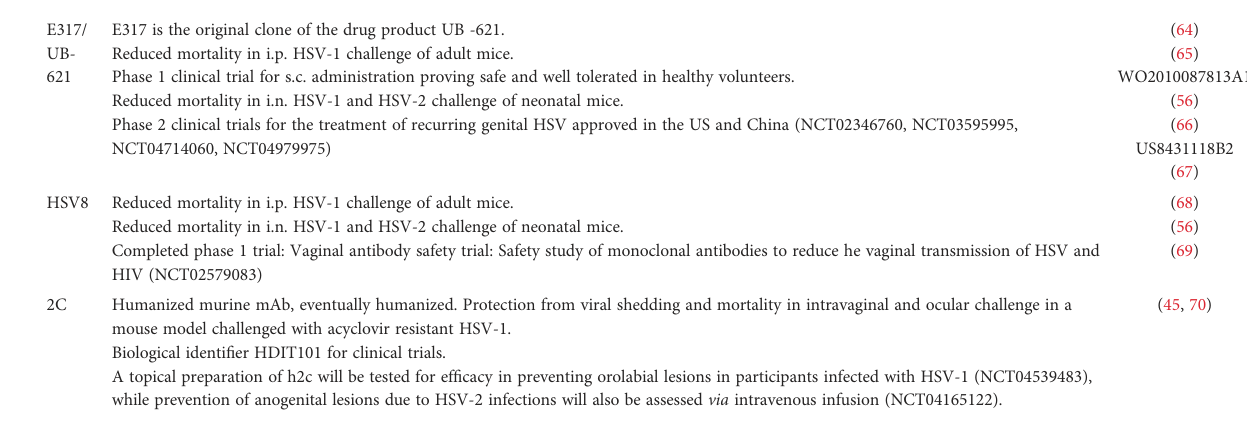
TABLE 2 HSV-speci fi c mAbs in clinical